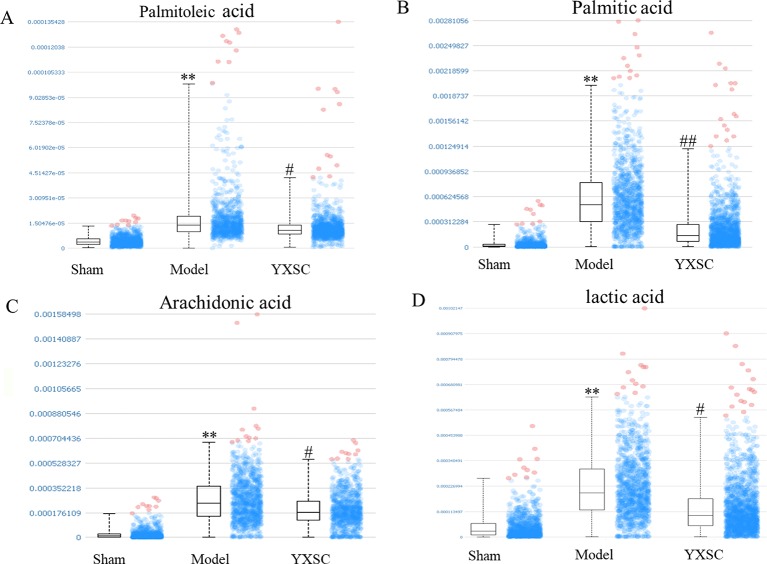
The ion intensity of palmitoleic acid, palmitic acid, arachidonic acid, and lactic acid extracted from the region of apoptosis on the heart section. Data were shown as the mean ± SD (n = 5). Asterisk mark and octothorpe mark indicate significant differences (** p < 0.01, sham group versus model group; ## p < 0.01, # p < 0.05, model group versus YXSC group). (A) (Palmitoleic acid, [M-H]- m/z 253.217), (B) (Palmitic acid, [M-H]- m/z 255.237), (C) (Arachidonic acid, [M-H]- m/z 303.234), (D) (lactic acid [M-H]- m/z 89.025).